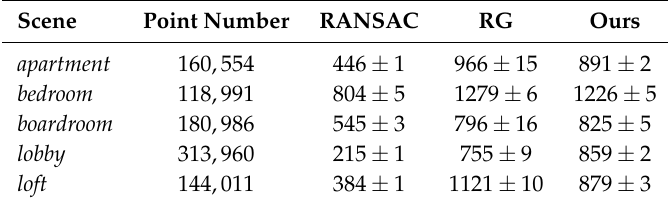
Table 3. Runtime in LiDAR-RGBD Scan Dataset (Points/ms).